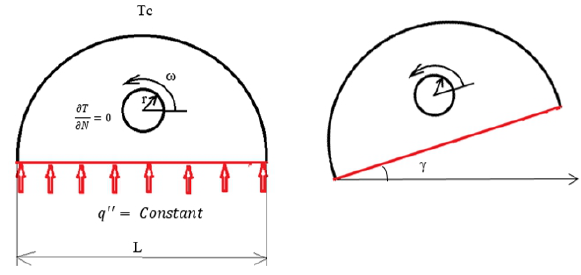
Fig. 1. Physical model and